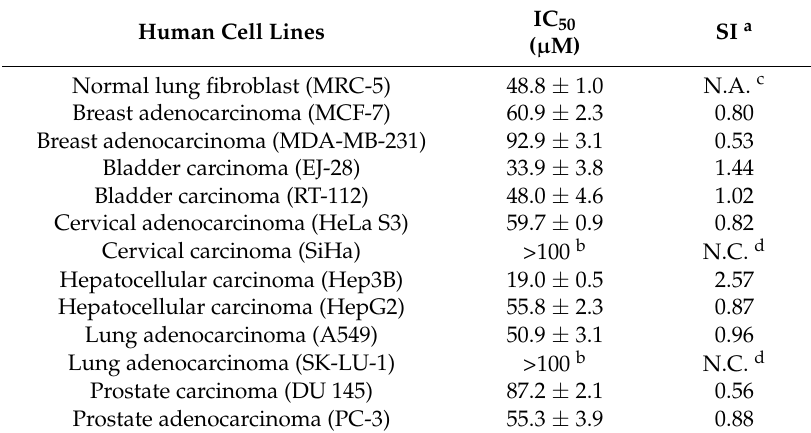
Table 1. The effects of pinnatane A treatment for 24 h on various cell